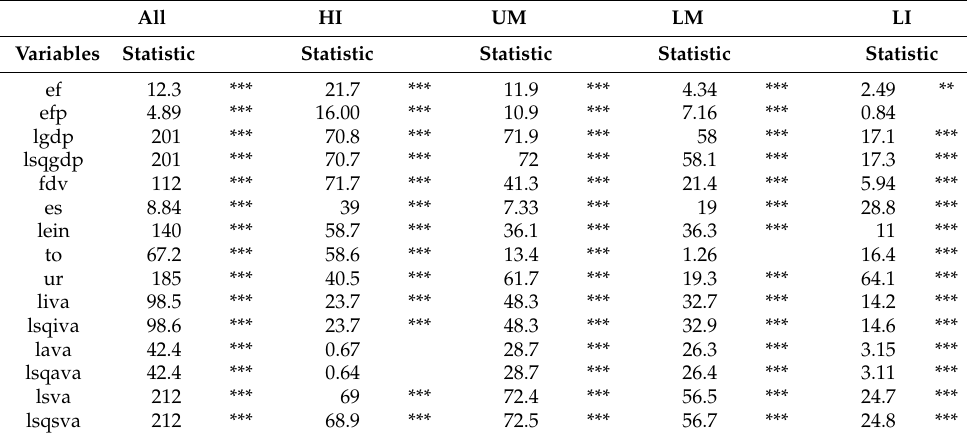
Table 2. Pesaran (2004) CD test for cross-sectional